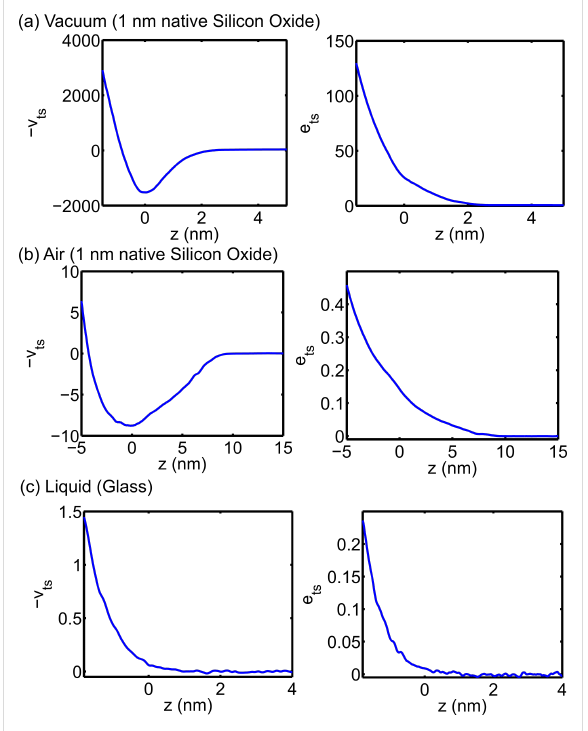
Figure 1: Experimental tip–sample virial v ts ( z , a sp ) and dissipation e ts ( z , a sp ). Data acquired in vacuum on a silicon sample with 1 nm native silicon oxide (a) in vacuum and (b) in air. (c) Data acquired in deionized water on a glass substrate. The set-point amplitudes were 8.5 nm, 8.6 nm, and 1.5 nm, respectively. See the Methods section for additional